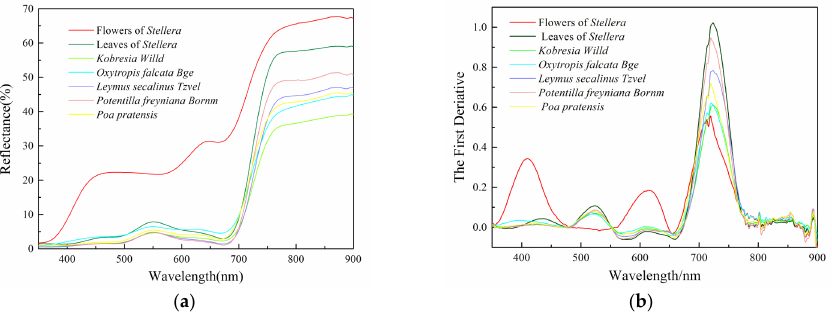
Figure 6. Reflectance spectra ( a ) and first-order differential spectra ( b ) of the white flowers, leaves of S. chamaejasme , and leaves of pasture grasses.